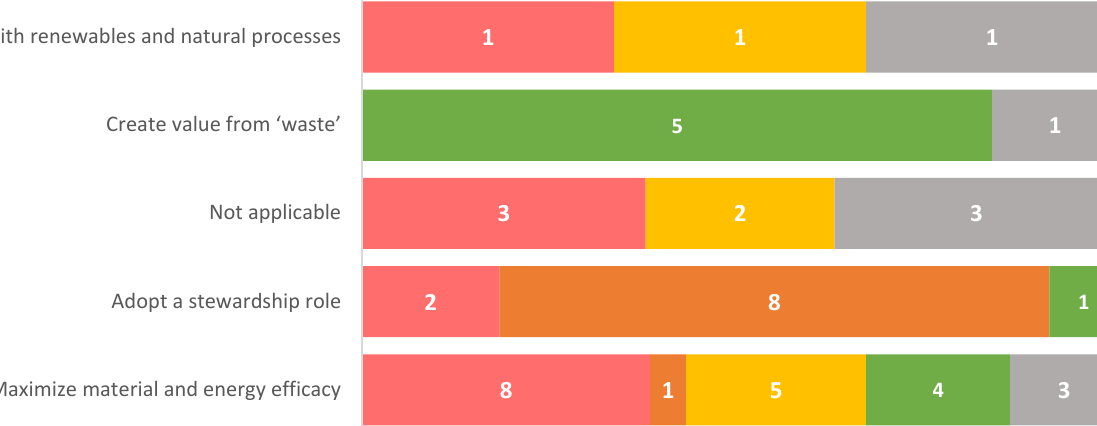
Figure 4. SBM archetypes by research area. Source: own study.